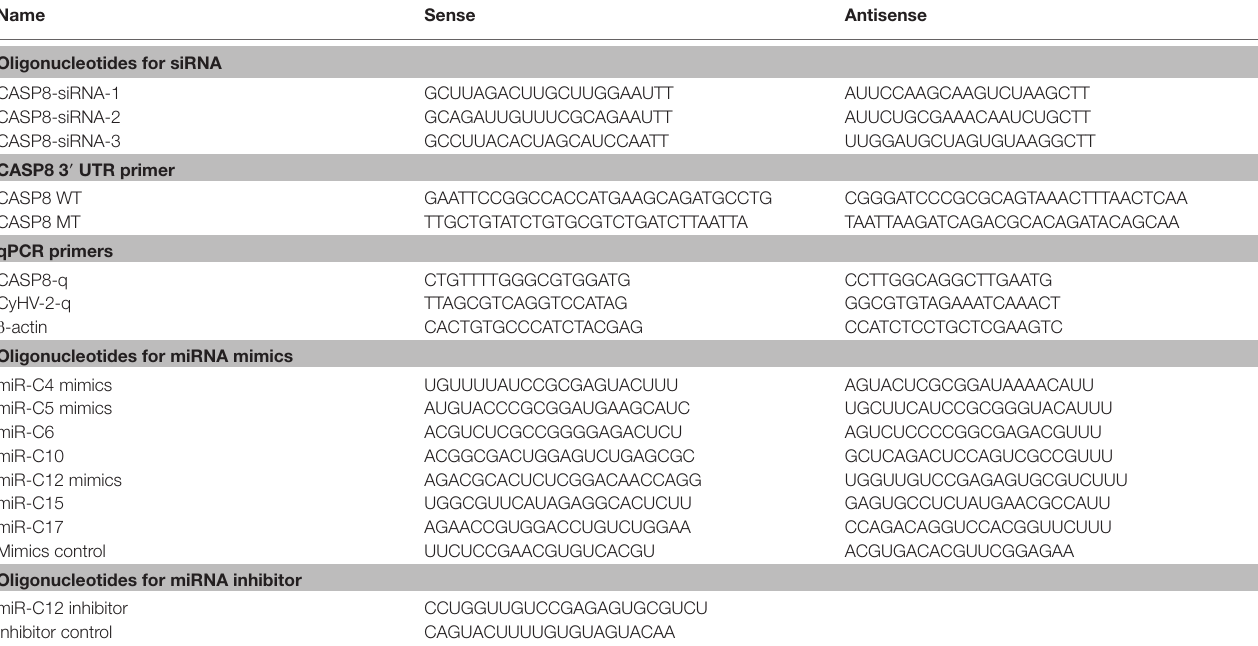
TABLE 1 | Oligonucleotide primers used for amplifying cDNAs, expressing constructs, and gene expression